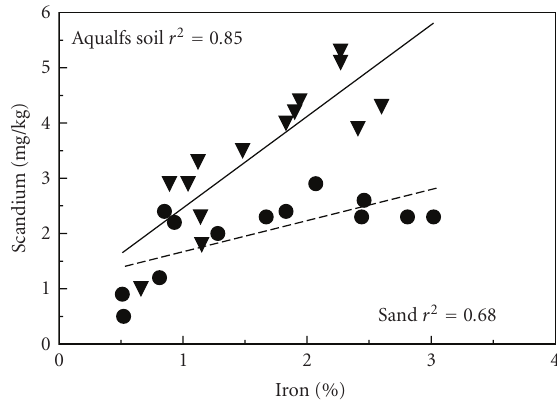
Figure 5: Scandium-iron distribution for the Aqualf pedons.